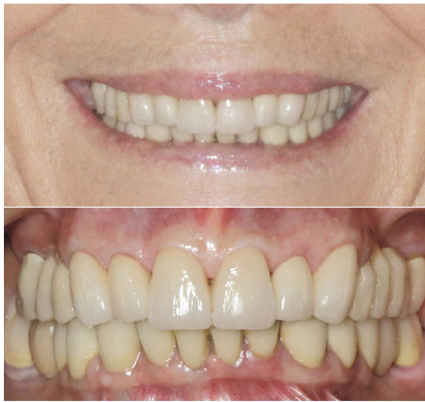
Figure 14: Final rehabilitation at the two-year follow-up with the new smile after the correction of the deep bite and gummy smile.